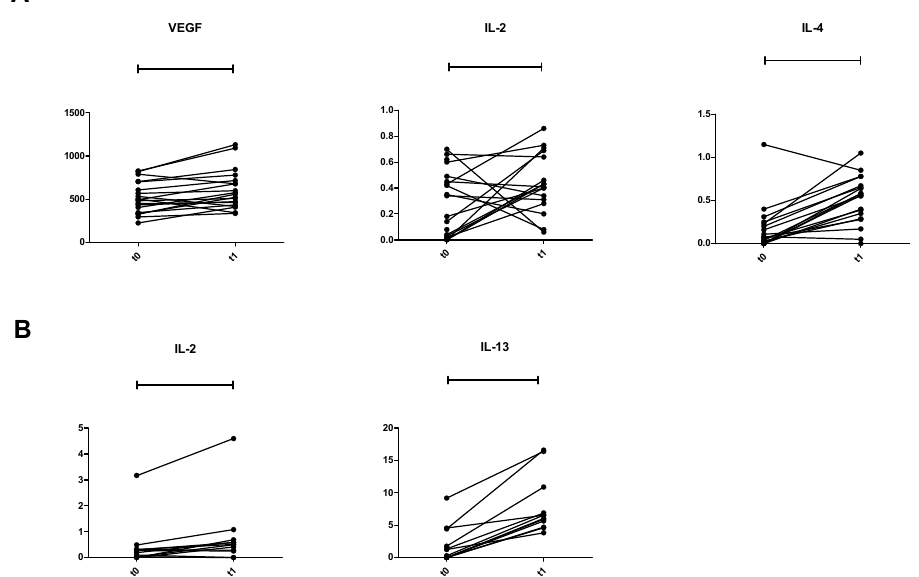
Figure 4. Longitudinal cytokine variation. ( A ) Spaghetti plot of 19 patients included in C3 from T0 to T1. ( B ) Spaghetti plot of 12 patients included in C2 from T0 to T1. IL, interleukin.